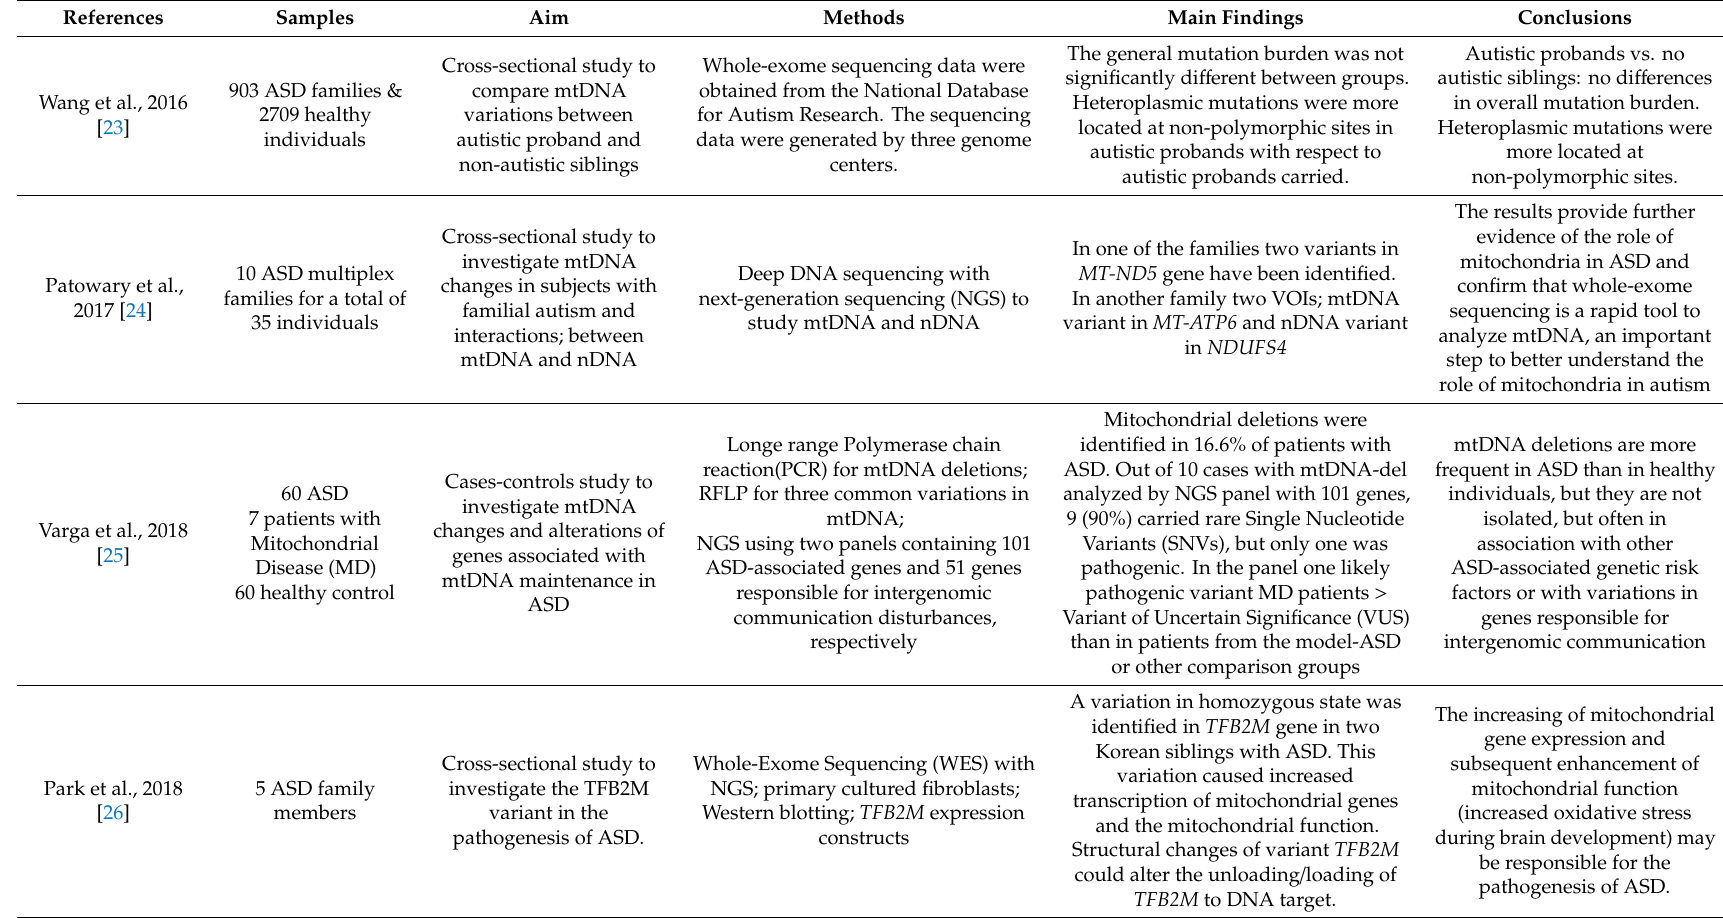
Table 1. Main findings of studies assessing the impact of genetic variations in mtDNA in patients with Autism spectrum disorder (ASD). For a list of abbreviation see Abbreviations